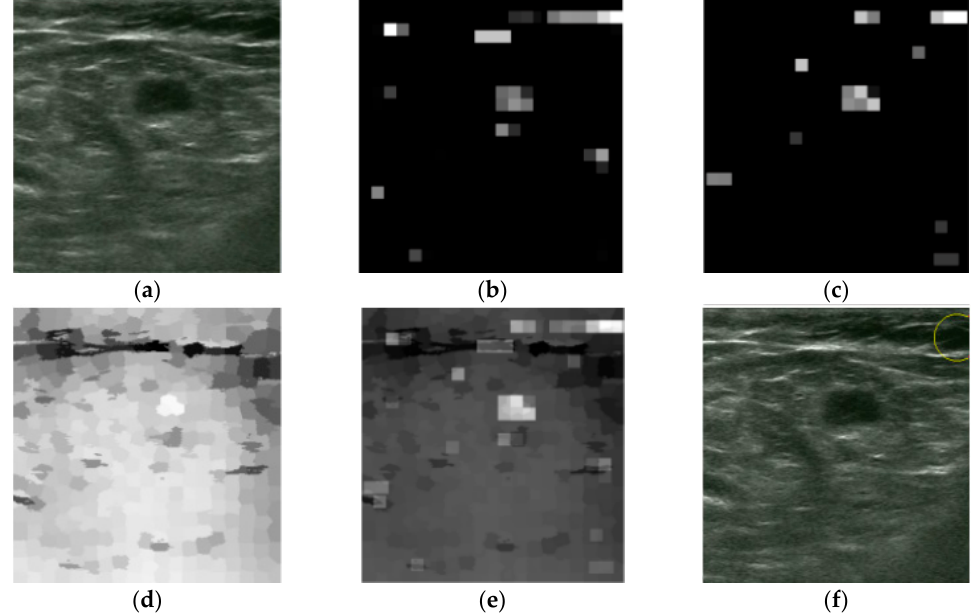
Figure 15. An example of wrong localization by the proposed method. ( a ) Original image, ( b ) intensity saliency map, ( c ) blackness ratio saliency map, ( d ) superpixel saliency map, ( e ) combined saliency map of three features, and ( f ) localization results.